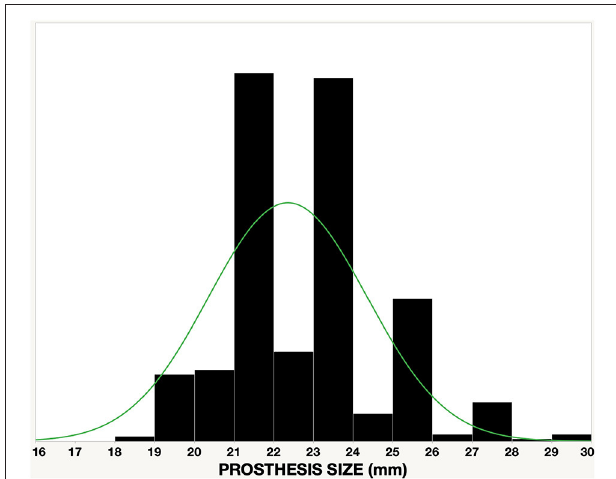
FIGURE 1 | Size distribution of surgically implanted valves in a cohort of 350 patients with mainly rheumatic aortic regurgitation at Groote Schuur Hospital, University of Cape